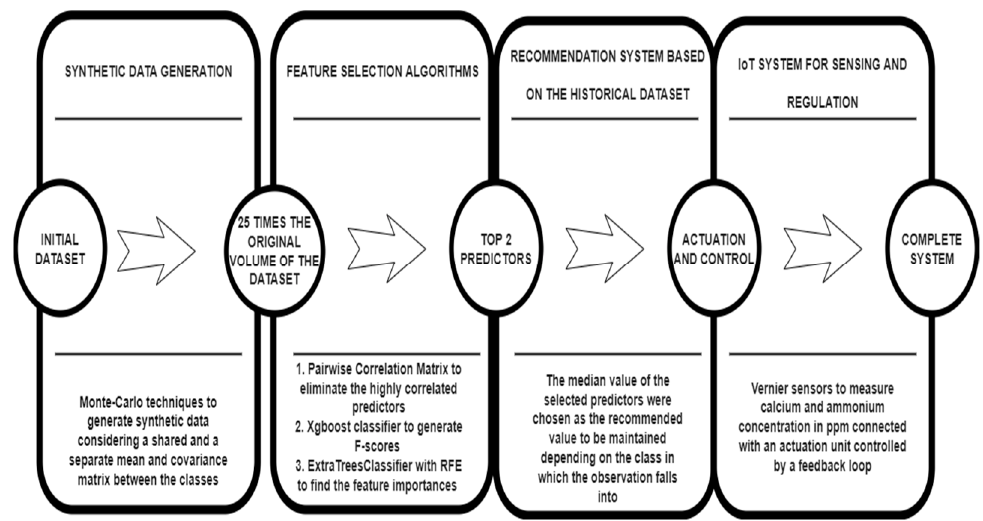
Figure 3. Pipeline of the complete system for sensing and actuation of nutrients for coupled systems in commercial aquaponic set-ups.